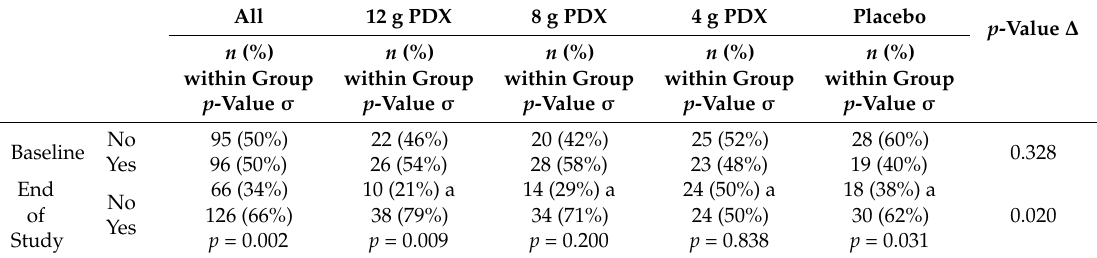
Table 6. Response to the relief of constipation questionnaire at baseline (Day 0) and end of study (Day 15) for participants in the intention-to-treat population ( n =